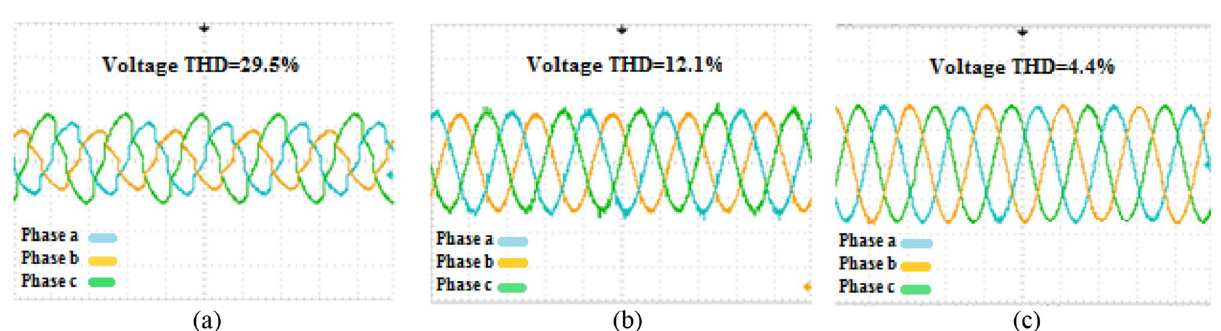
Figure 20. The experimental results of the voltage THD; ( a ) THDv without compensator, ( b ) THDv with UPQC, ( c ) THDv with